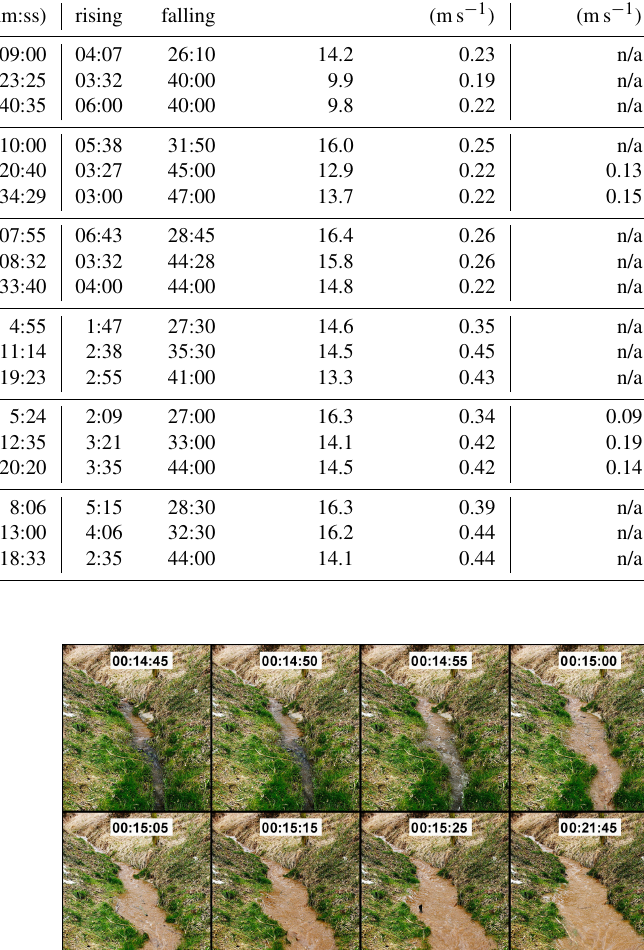
Table 2. Hydrograph characteristics. n/a: data not available. Wave no.